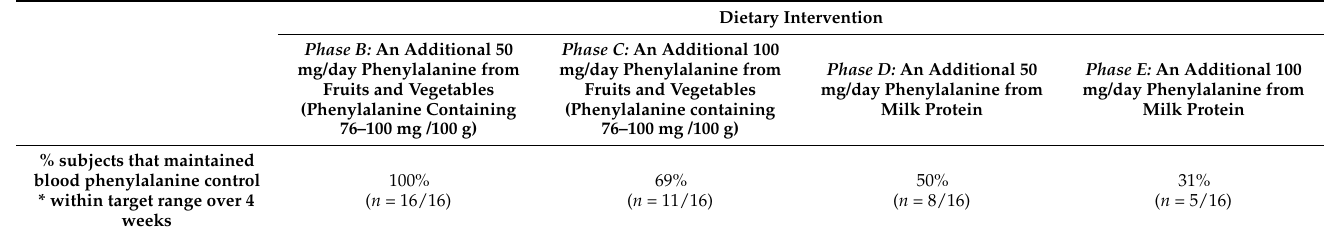
Table 3. Tolerance of additional phenylalanine in children with PKU from either fruits/vegetables or milk